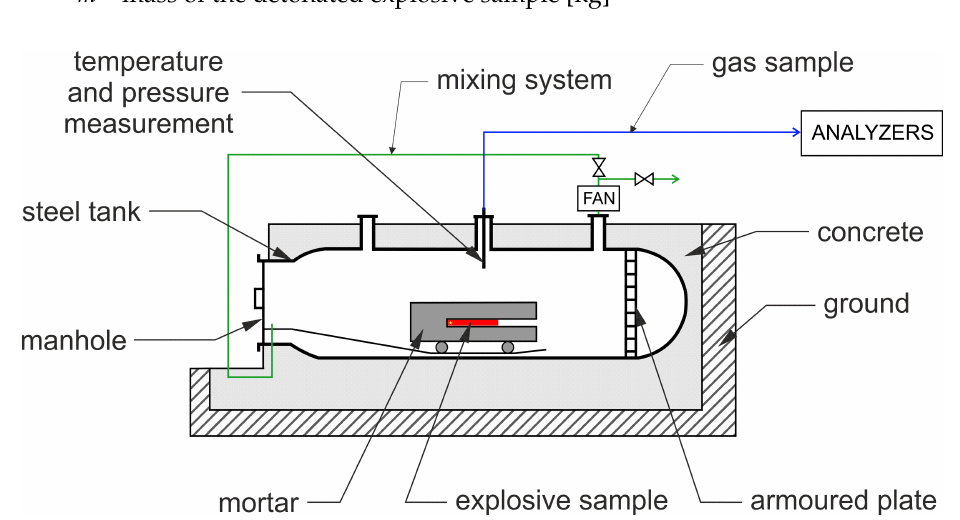
Figure 3. Blasting chamber for post-detonation gases analysis (based on